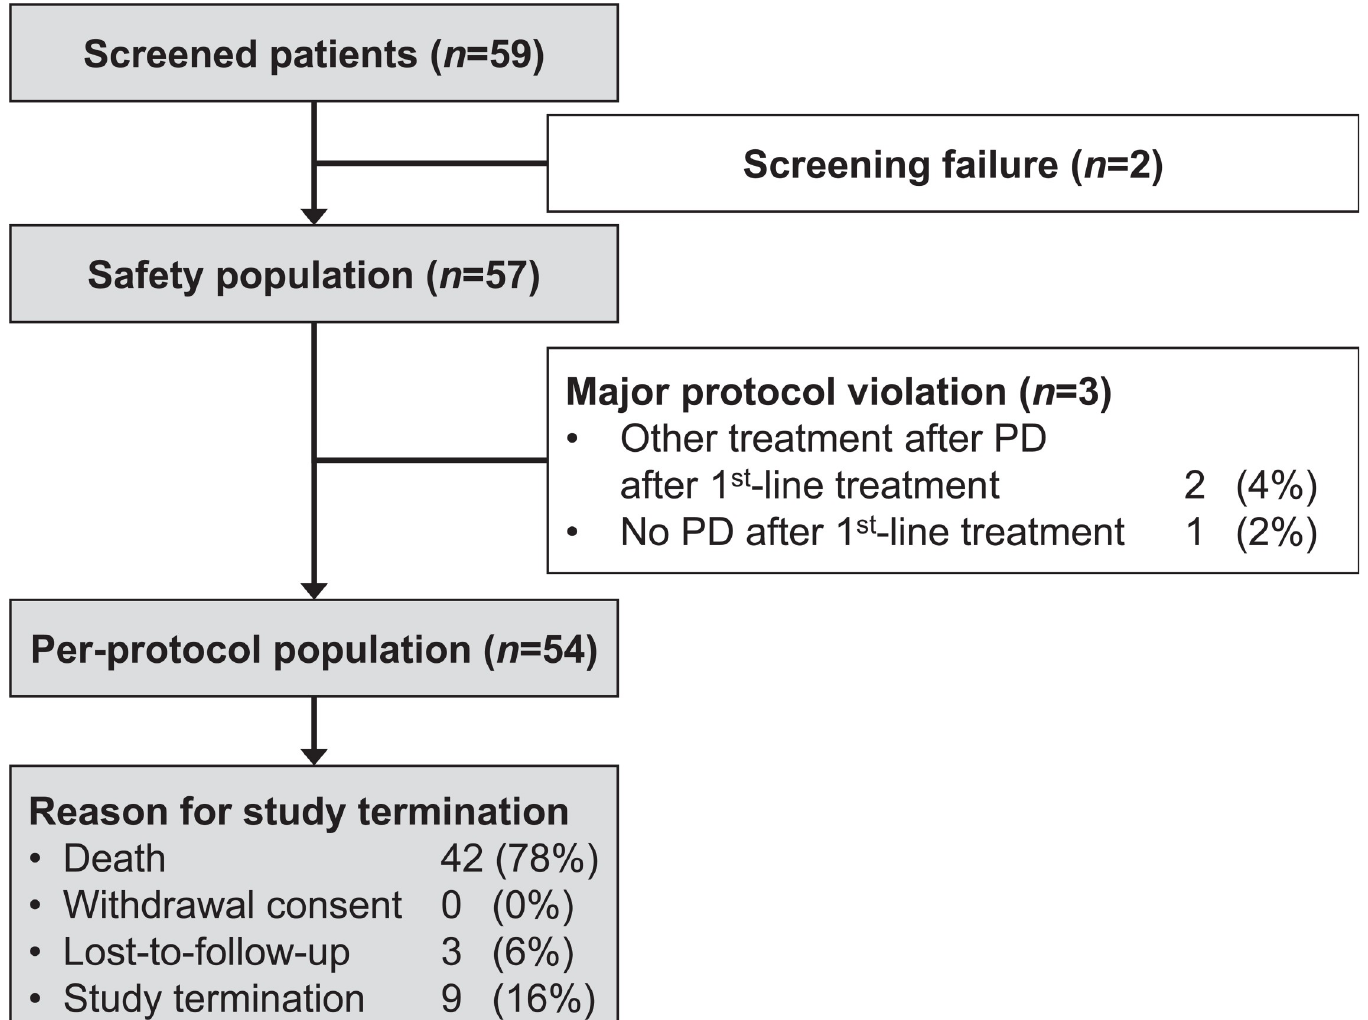
Fig 1. CONSORT diagram of